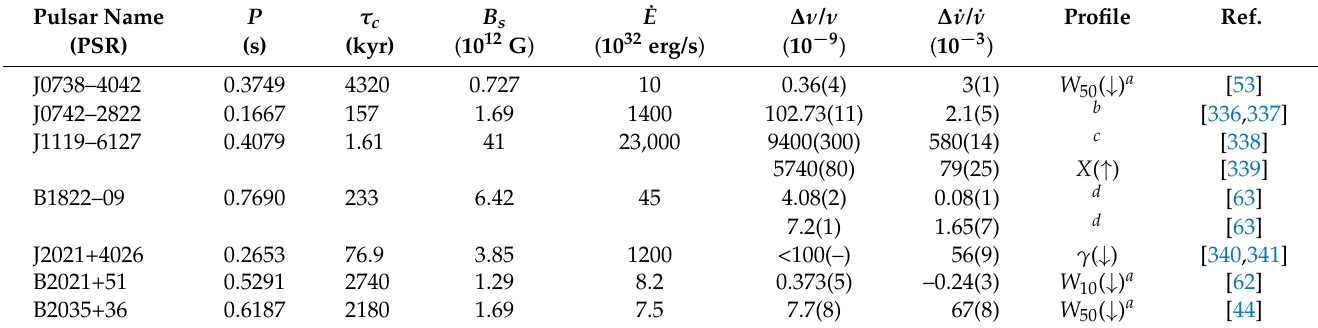
Table 2. Detailed parameters for pulsars exhibited correlation between glitches and emission